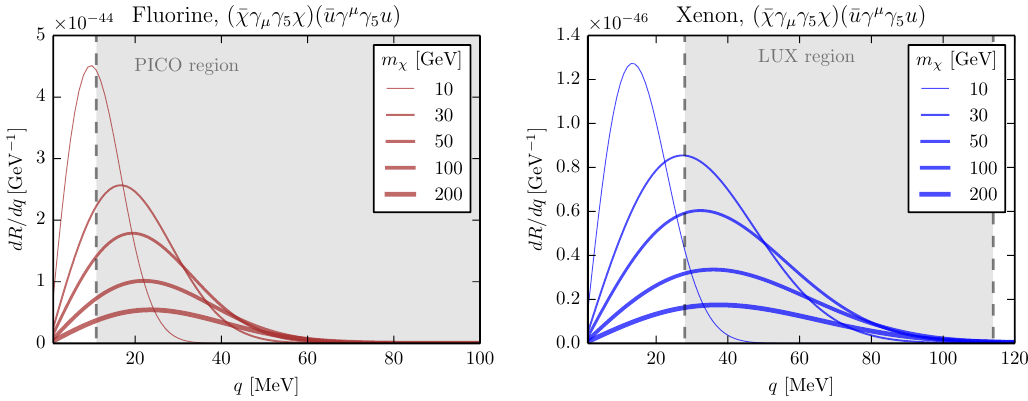
Figure 1 . The momentum exchange distributions for DM scattering on a representative light nucleus, 19 F, (left) and heavy nucleus, Xe, (right) for spin-dependent scattering. The Wilson coe(cid:14)cient of the operator is set to (1 TeV) (cid:0) 2 in both cases and we summed the contributions of the xenon isotopes weighted by their natural abundances. The curves of di(cid:11)erent thicknesses correspond to di(cid:11)erent dark matter masses in GeV as shown in the plot legends. The approximate experimental thresholds are denoted by dashed vertical lines. For (cid:13)uorine, we use the PICO threshold region E R > 3 : 3 keV [28] while for LUX, we use the approximate region E R [3 ; 50] keV [29]. 2 higher orders in the ( q= (cid:3) ChEFT ) 2 expansion up to the order where two-nucleon currents